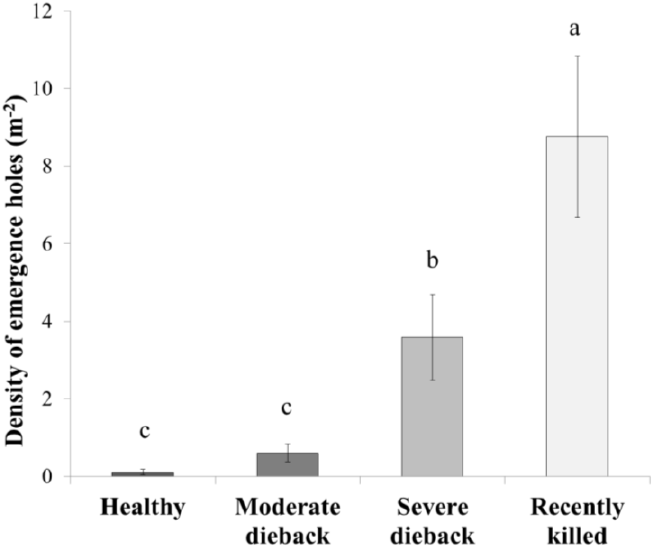
Figure 6. The density of emergence holes (m −2 ) of Phoracantha semipunctata in trees with different crown health classes within severely-affected forest areas across 11 sites in the Northern Jarrah Forest, southwestern Australia. Significant differences between emergence holes in trees with health classes were found from Kruskal–Wallis tests at alpha = 0.05. Columns sharing the same letter are not different from individual Mann–Whitney tests with Bonferroni correction. Error bars represent the standard error of the